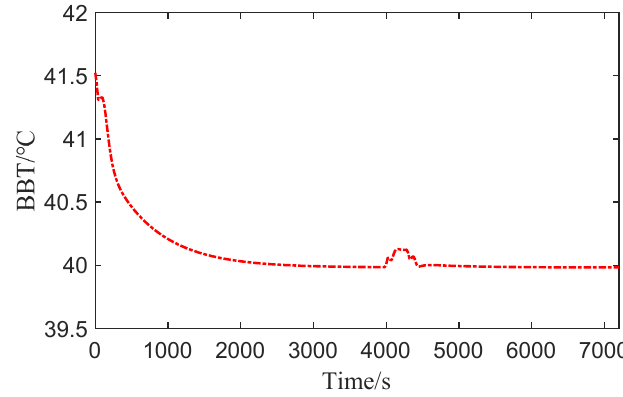
W W . Figure 24. Dynamic of BBT for step increase in W Re .